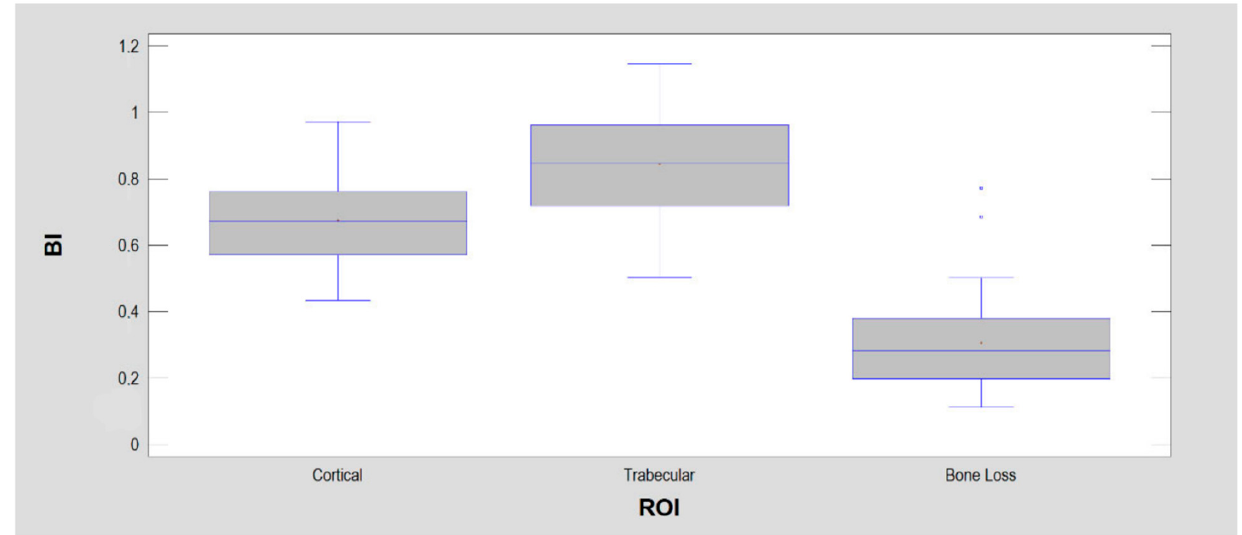
Figure 4. The bone index (BI) was calculated for the detection of normal bone (i.e., trabecular bone) within dental alveolus during guide bone regeneration. That is why BI reaches the highest values in ROI 2 representing trabecular bone. There are significant statistical differences between each ROI.